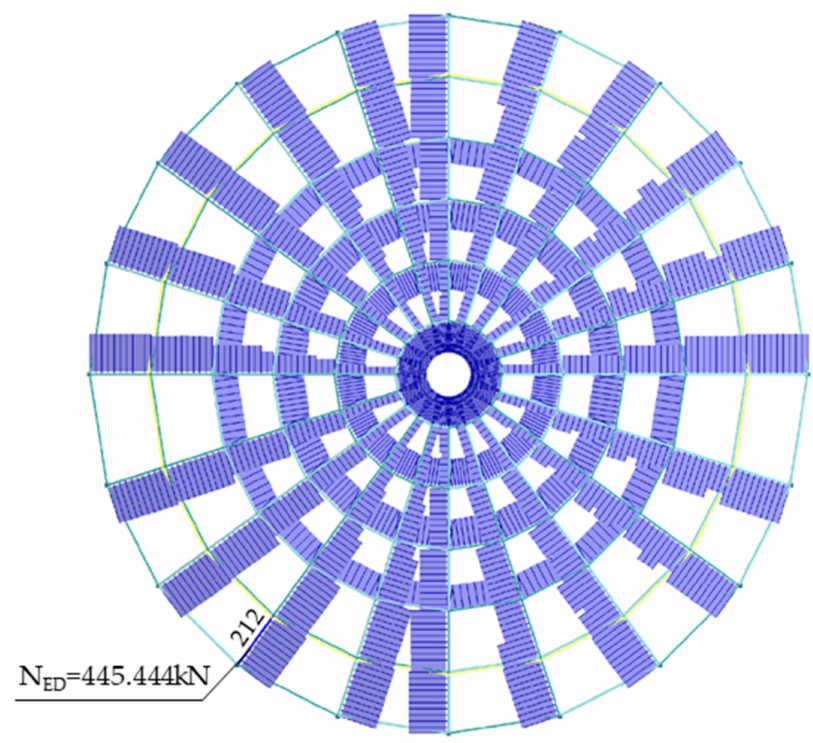
Figure 8. Axial force, N Ed